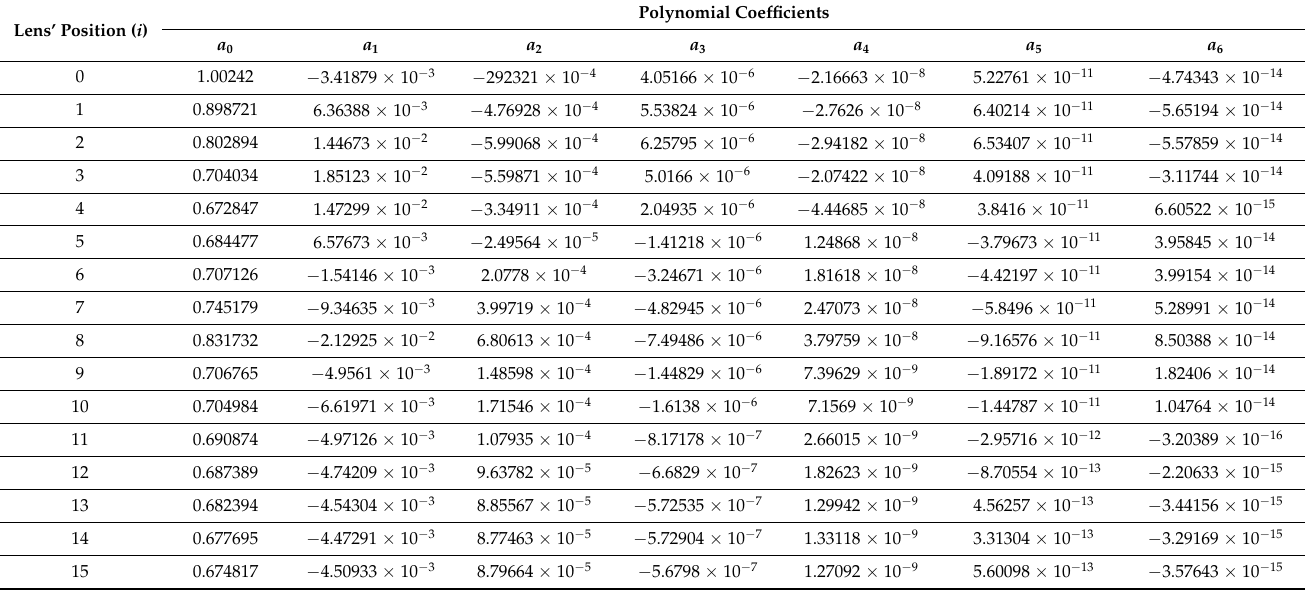
Table 1. Polynomial coefficients determined for each lens position.